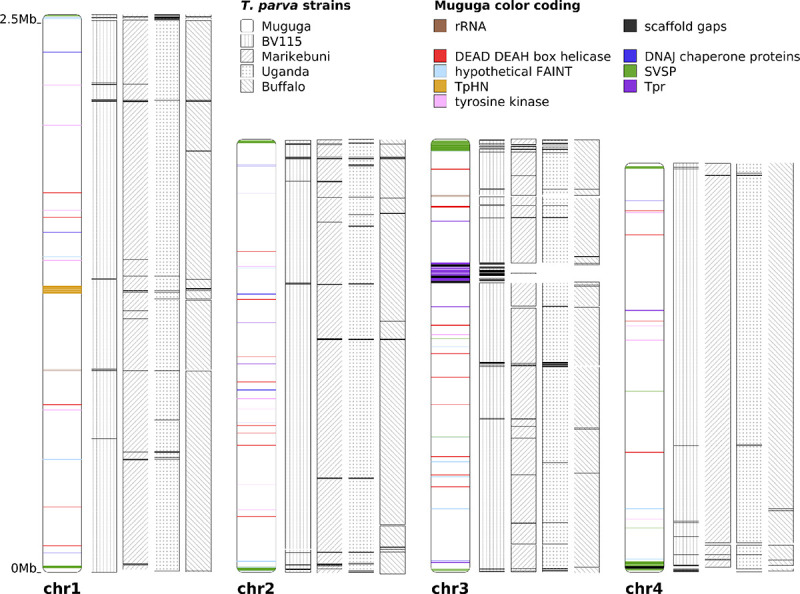
De novo genome assemblies for four T. parva isolates.In the reference assembly (Muguga), chromosomes 1 and 2 are represented by single scaffolds. The four contigs representing chromosome 3 and the two contigs of chromosome 4 were each merged and are shown as a single scaffold. Assemblies for the four new isolates were generated with SPAdes, and aligned to the T. parva Muguga reference, using nucmer. Scaffold placement was centered on the midpoint of each alignment. All gene families with >10 paralogs are colored in the reference Muguga strain. The main genomic regions underrepresented in the new assemblies contain several members of T. parva multigene families, including the Tpr locus (a total of 24 Tpr genes within the two contigs central in chromosome 3), and SVSP family (15 SVSP genes in the first 20kb in the 5′ end of chromosome 4, shown at the bottom).